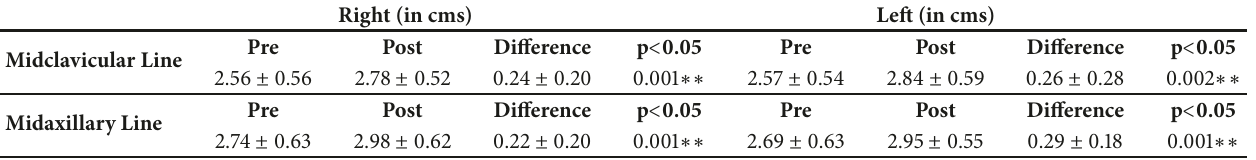
Table 3: Comparison of Diaphragmatic Excursion before and after the Manual Diaphragm Release Technique. Right (in cms) Left (in cms) Midclavicular Line